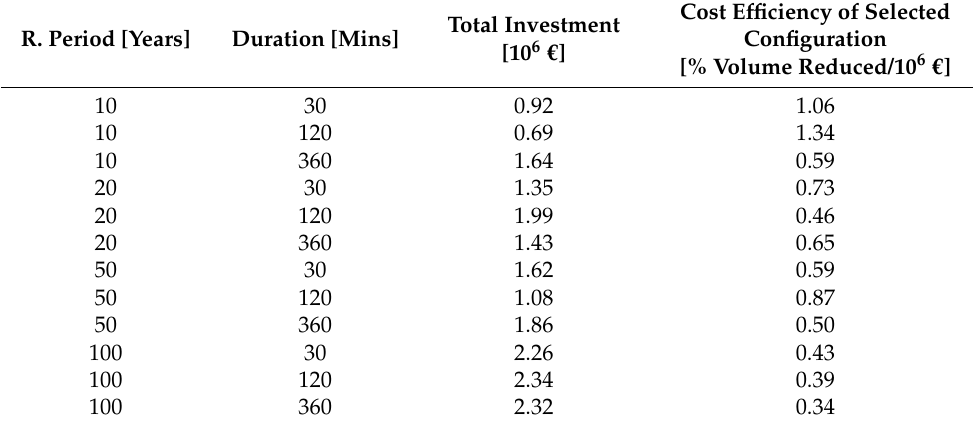
Table 7. Cost efficiency for the 12 rainfall